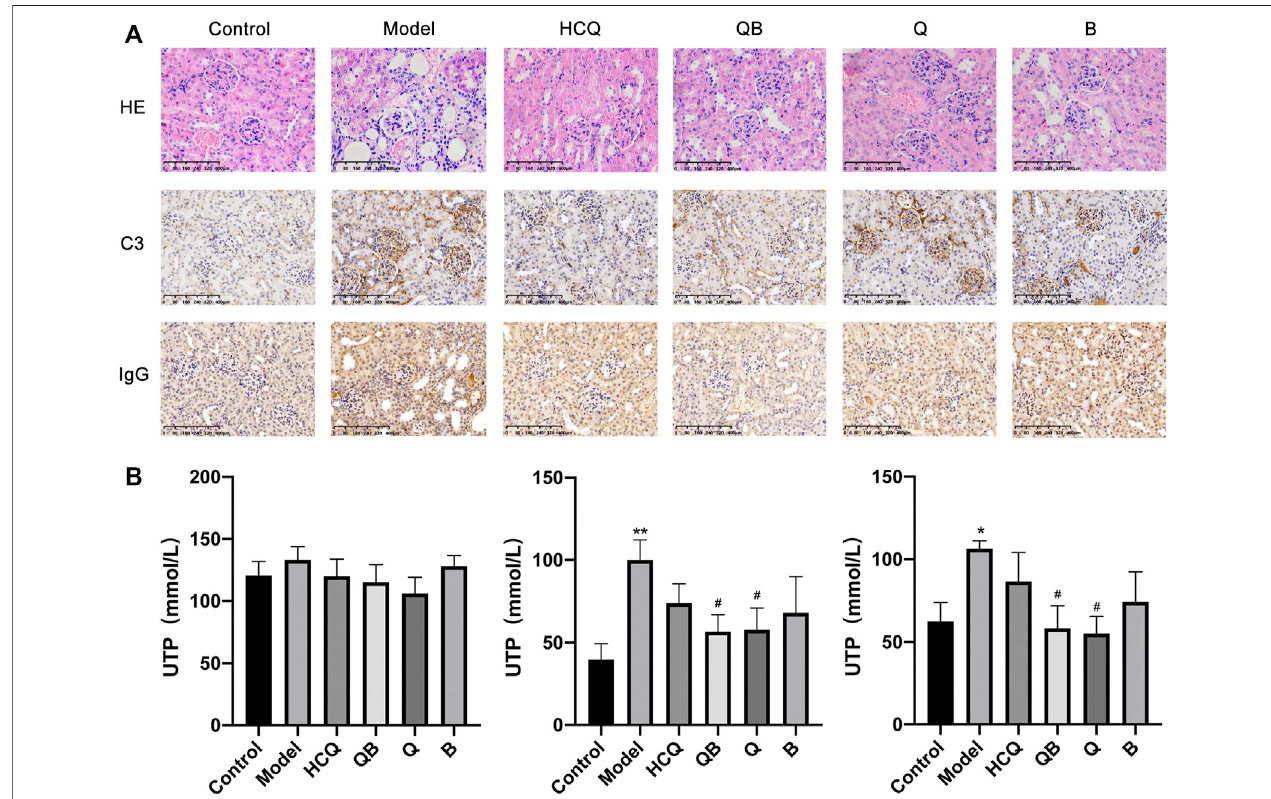
FIGURE3| Qinghao-Biejiacanimproverenalinjury. (A) PathologicalchangesinthespleenwereassessedbyHEstainingandrepresentativeimmunohistochemical staining for C3 and IgG (All images are x400). (B) The proteinuria levels of the mice (after 4 weeks of dosing, after 8 weeks of dosing, and after 12 weeks of dosing, respectively).Thedataareexpressedasthemean±SEM.Modelgroupcomparedwiththecontrolgroup,* p < 0.05,** p < 0.01;theremaininggroupscomparedwiththe model group, # p <